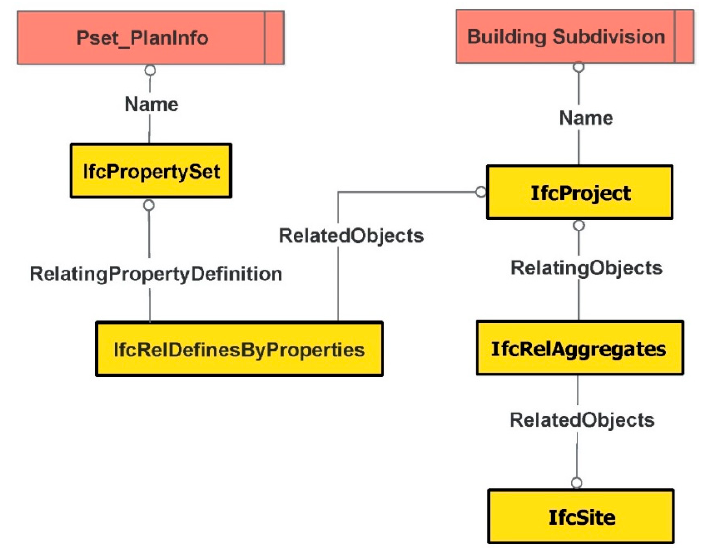
Figure 10. Modelling administration information within the IFC standard.